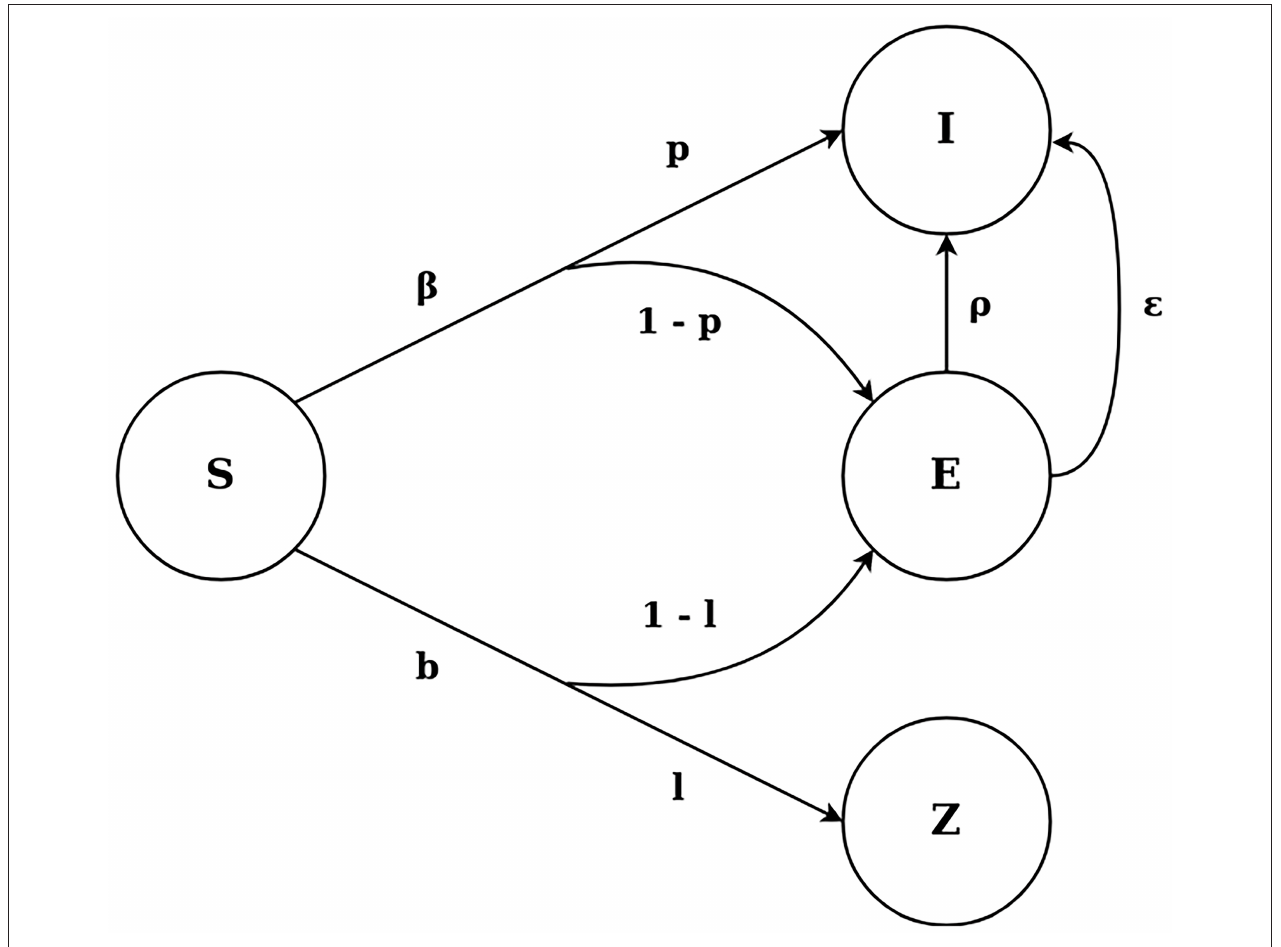
FIGURE 1 | The SEIZ model.